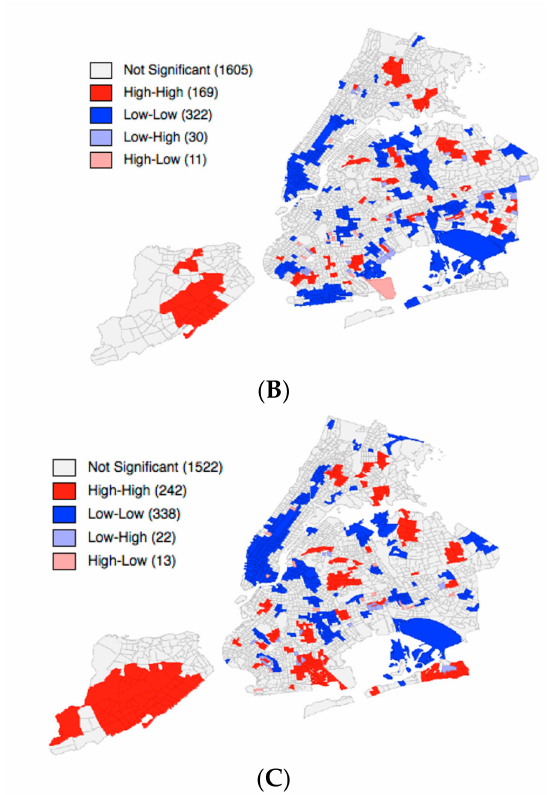
Figure 2. Local clusters of above average discomfort rates (shaded in red) in NYC geo-located Twitter tweets for the three periods before ( A ), during ( B ) and after ( C ) Superstorm Sandy, indicating that high rates were found next to other high rates (High-High). Rates were smoothed with the spatial empirical Bayes smoother prior to the cluster analysis. Notably, the statistic also calculates below average rates (low rates next to other low rates) and outliers (high rates next to low rates and vice versa) that are not considered in this study. Table 3. Spatial regression results. Model 2 is a spatial lag regression model with regimes, i.e., the boroughs. Peri-Disaster Discomfort Post-Disaster Discomfort Variable Coef. S.E. Coef.